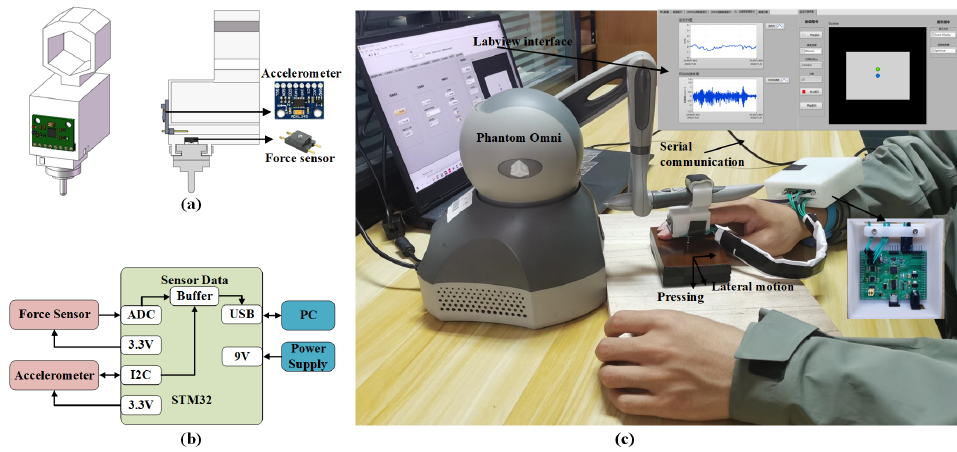
Figure 3. ( a ) The schematic diagram of the wearable fingertip device. ( b ) The block diagram of the STM32 board at the wrist. ( c ) Haptic data recording